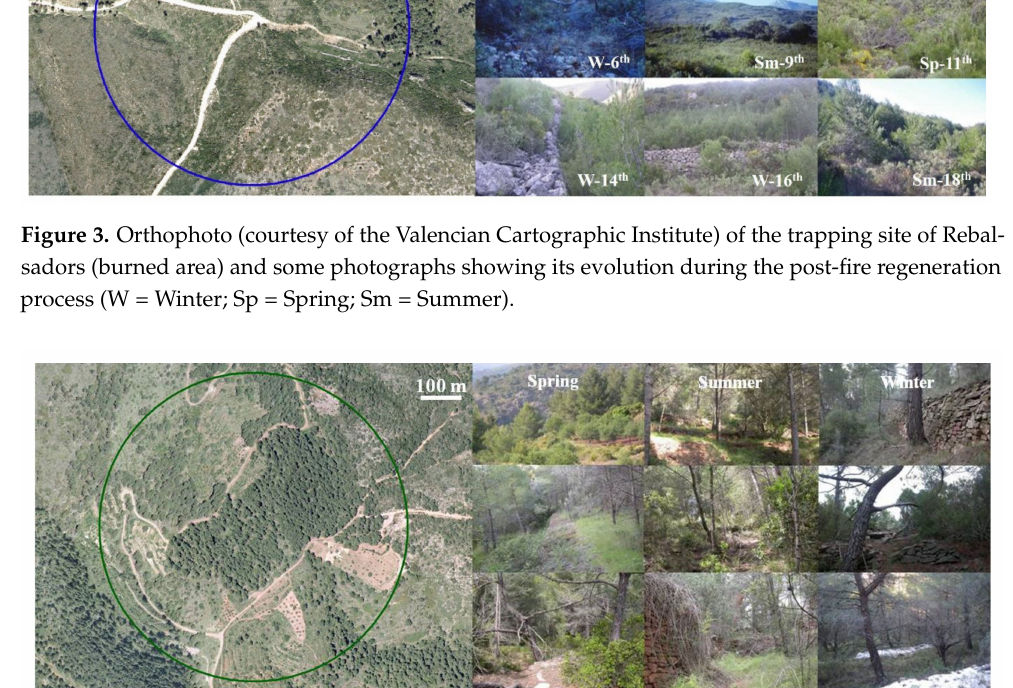
Figure 4. Orthophoto (courtesy of the Valencian Cartographic Institute) of the trapping site of Les Llomes (control area) and some seasonal photographs taken during the study